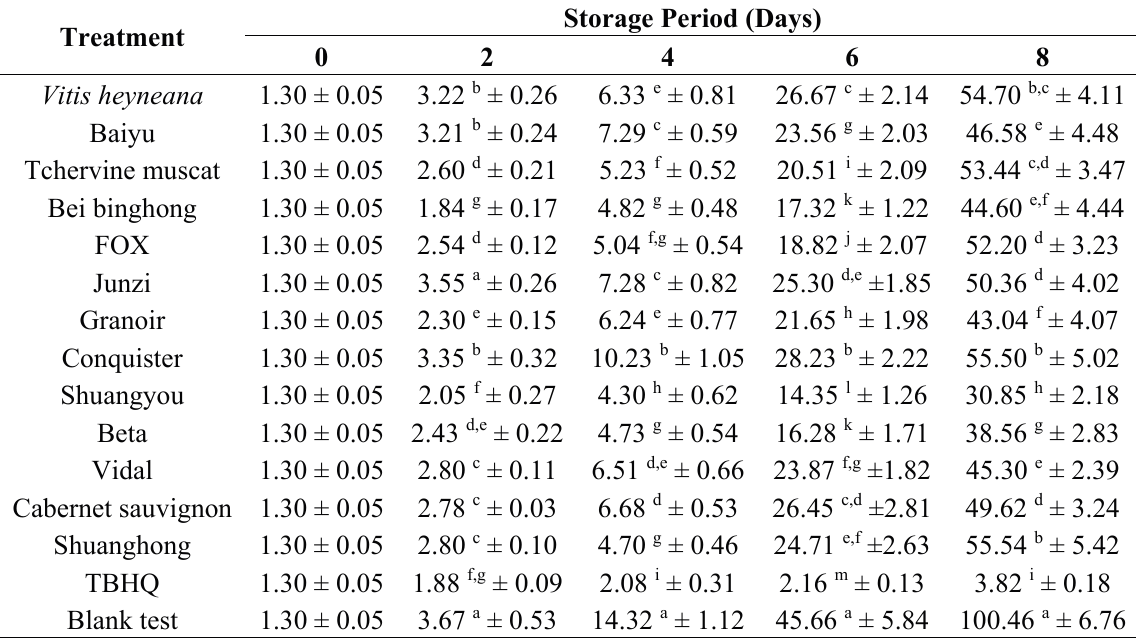
Table 1. Peroxide value (POV) (meqO 2 /kg sample) of edible oil samples treated with tert-butyl hydroquinone (TBHQ) and grape vine cane extracts by the methanol antioxidation test at 70 ± 1 °C, kept in the dark.